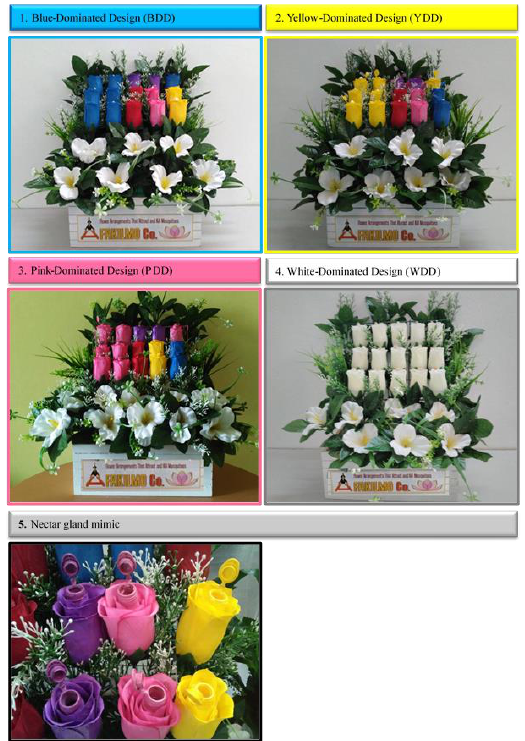
Figure 1. The experimental artificial floral designs used in this study. ( 1 ). Blue-dominated design (BDD). ( 2 ). Yellow-dominated design (YDD). ( 3 ). Pink-dominated design (PDD). ( 4 ). White-dominated design (WDD). ( 5 ). Nectar gland mimic present in all individual artificial flowers. BDD, YDD, and PDD were test floral designs, while WDD was the control. All these designs contained 15 artificial flowers arranged in a 3 × 5 design with the same amount of background greenery. All test floral designs possessed the same number of displayed colors but in varying proportions.